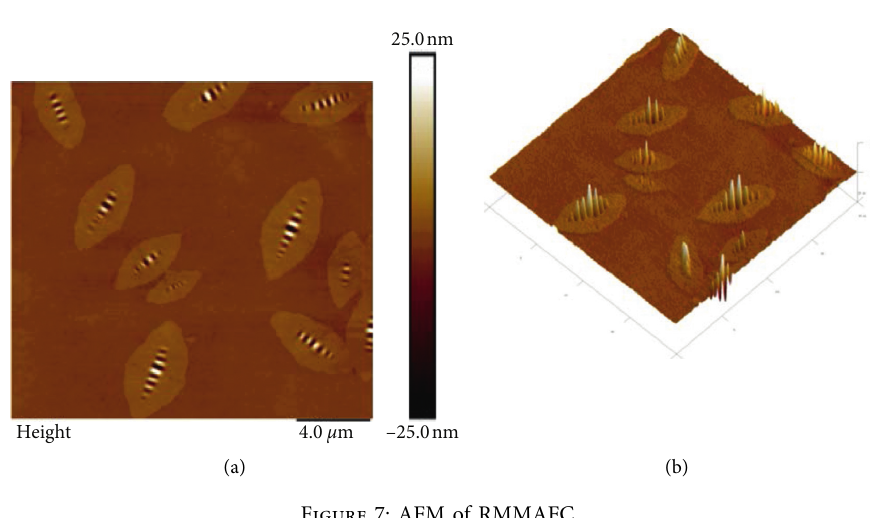
Figure 7: AFM of